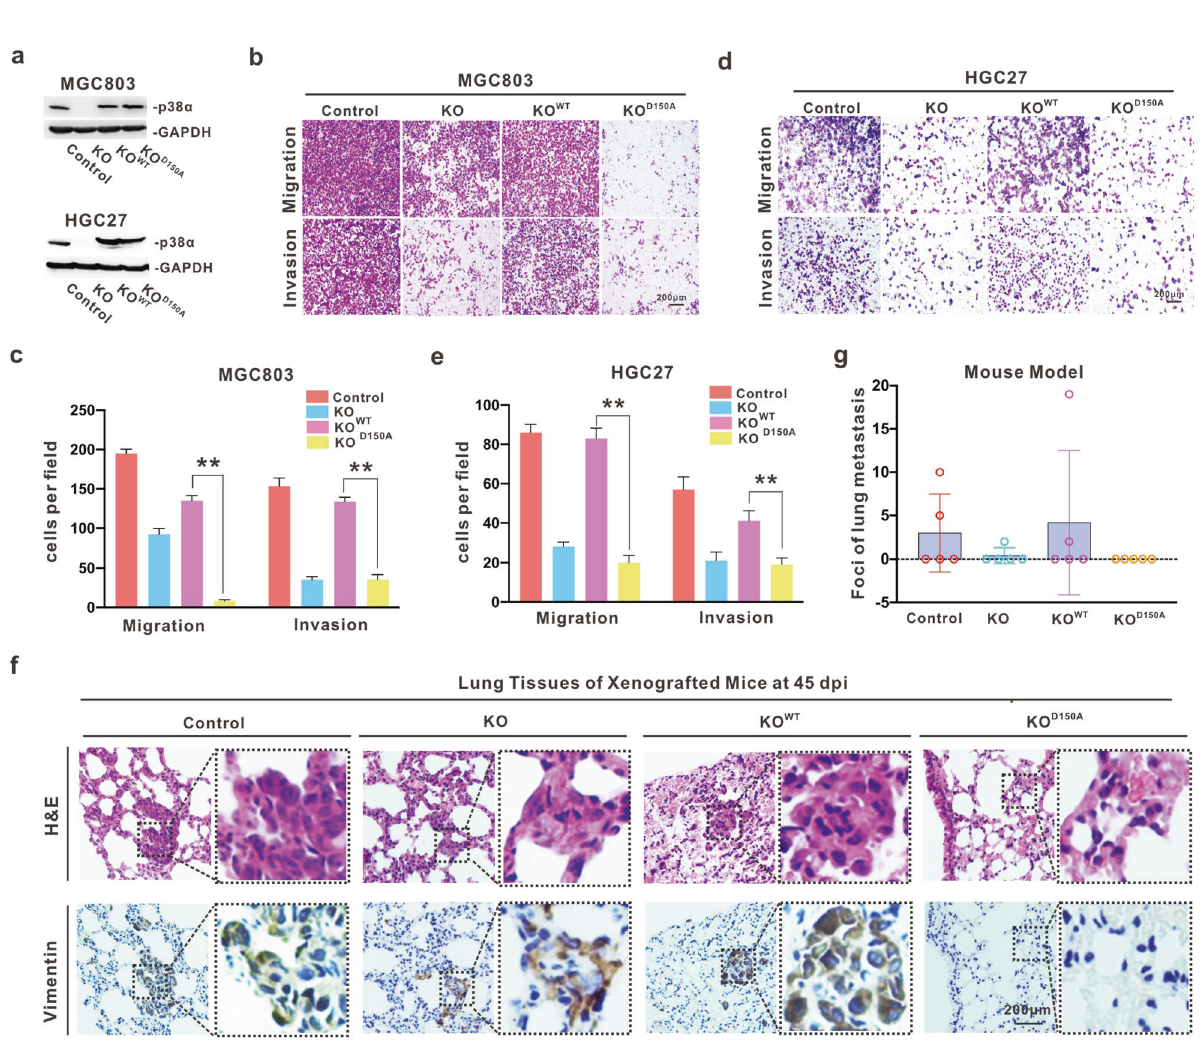
Fig. 3 p38 α -SUMOylation facilitates GC metastasis in vitro and in vivo. a Endogenous MAPK14 mRNA was disrupted for inducing p38 α - translationde fi ciency (KO) in both MGC803 and HGC27 cell lines using the CRISPR-Cas9 system, and exogenous HA-p38 α WT or HA-p38 α D150A were re-introduced into MGC803/MAPK14 KO and HGC27/MAPK14 KO cells by lentiviral infection. The expression of endogenous and exogenous p38 α proteins in those cell lines was analyzed by immunoblotting. b – e Migrated and invaded cells was stained with crystal violet and captured for this presentation ( b , d ). The number of positive cells that went through the out-bottom of inner chambers was statistically presented as the mean ± S.D. ** p < 0.01 ( c , e ). f – g The lungs of xenografted mice were collected for H & E staining and immunoblotting with anti-vimentin antibody at 45 days after tail intravenous injection with the indicated HGC27 stable cell lines. The representative images are presented, scale bar: 200 µm ( f ). The number of lung metastatic loci in each nude mouse is shown in the dot plot ( g ).